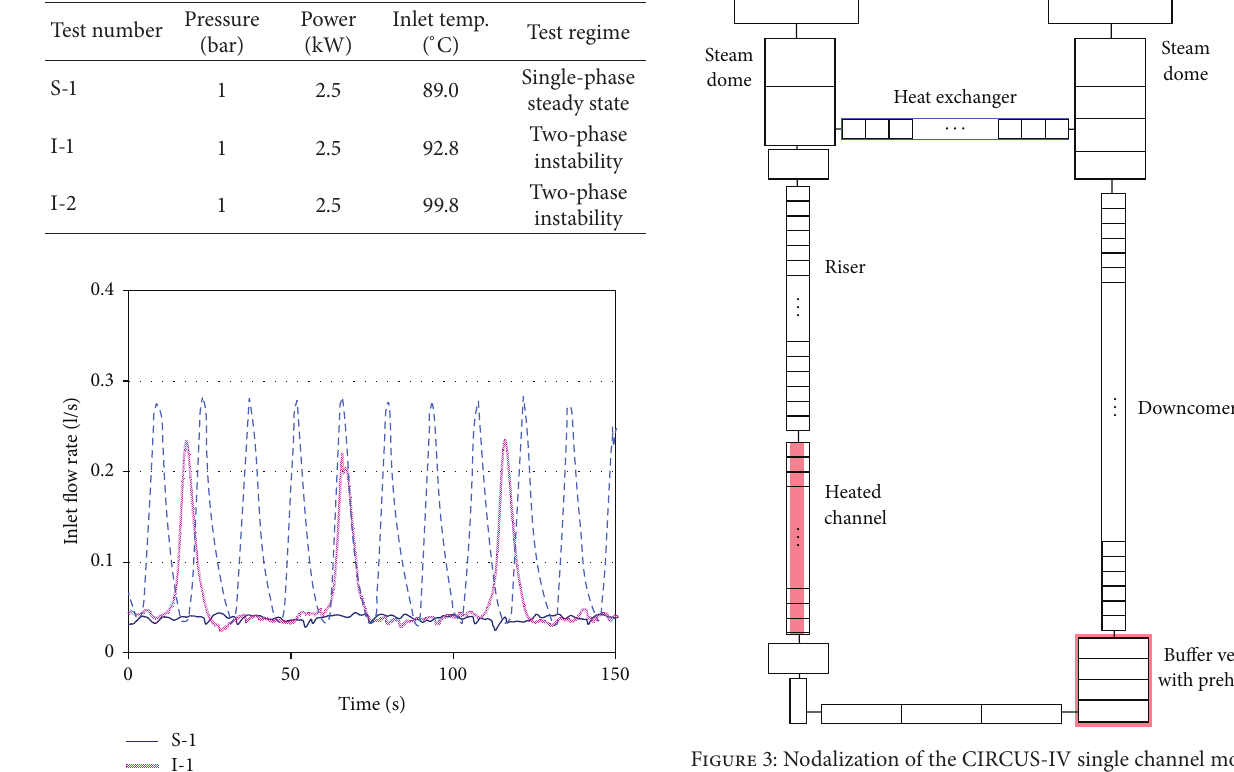
Figure 3: Nodalization of the CIRCUS-IV single channel model in